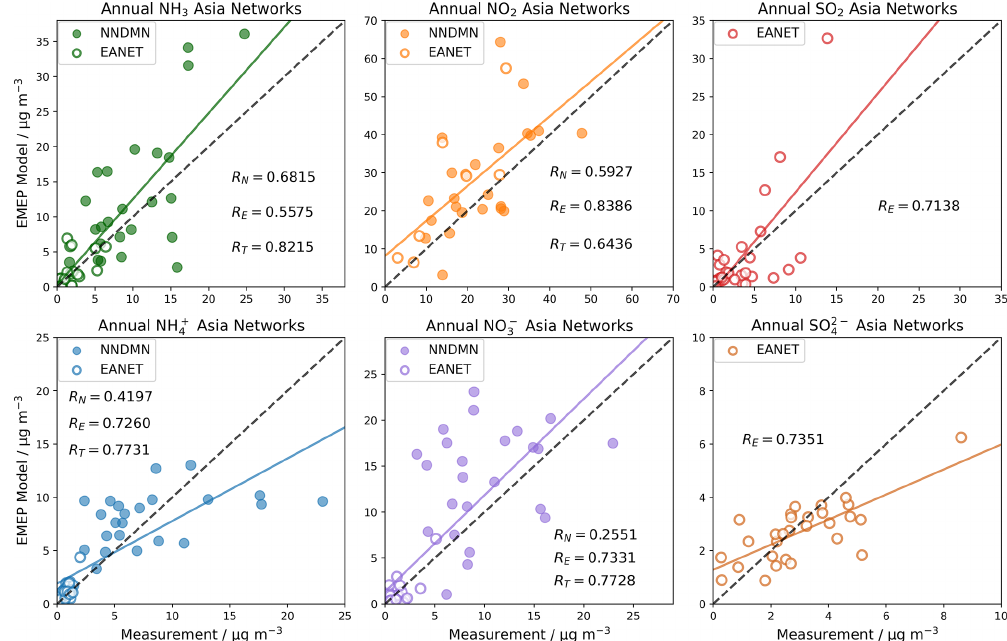
Figure 6. Scatter plots of 2015 annual mean modelled and measured NH 3 , NO 2 , HNO 3 , SO 2 , NH 4 + , NO 3 − , and SO 42 − concentrations at East Asian and Southeast Asian monitoring network locations. In each plot, the solid line is the least-squares regression line and the dashed black line is the 1 : 1 line. R N is for NNDMN network. R E is for the EANET network. R T is the overall correlation coefficient between the model and all measurements shown. Table 2. Summary statistics of model comparison with measurements for 2015 in East Asia and Southeast Asia (NNDMN and EANET networks). N is the number of paired data of model and observation. R N and R E are Pearson’s coefficients for NNDMN and EANET respectively. Fac2 is the fraction of data points within a factor of 2. Mean_O and Mean_M are annual average concentrations (µgm − 3 ) of observation and model respectively. NMB is normalized mean bias, NME is normalized mean